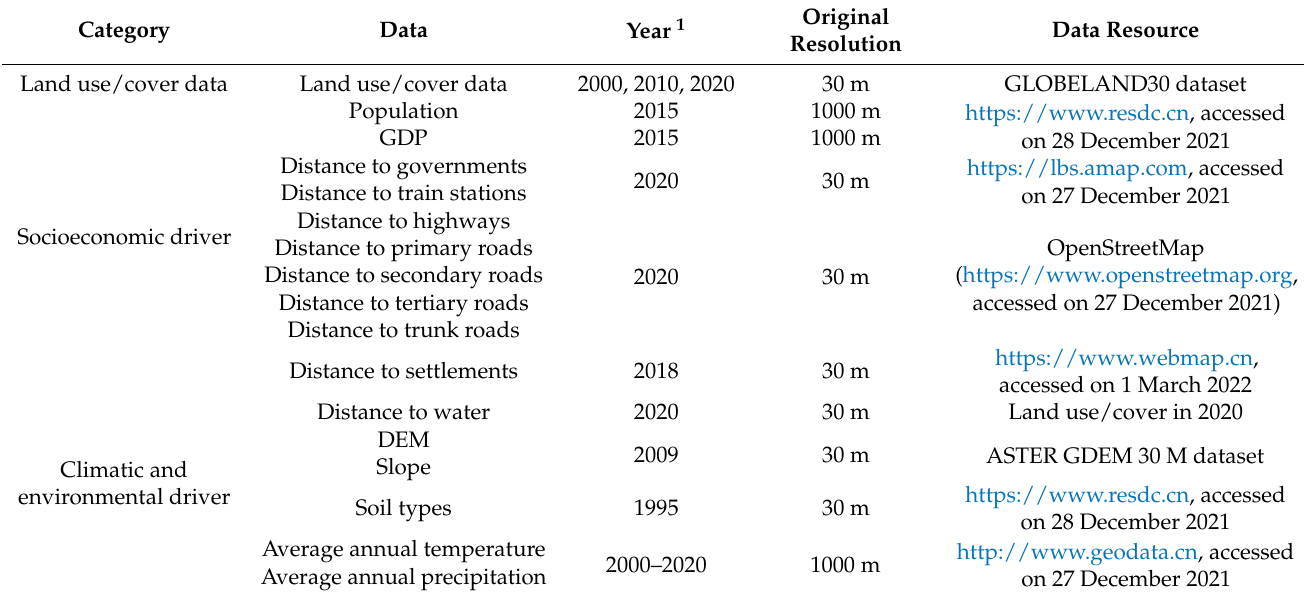
Table 1. Spatial driving factors of the land use change in this